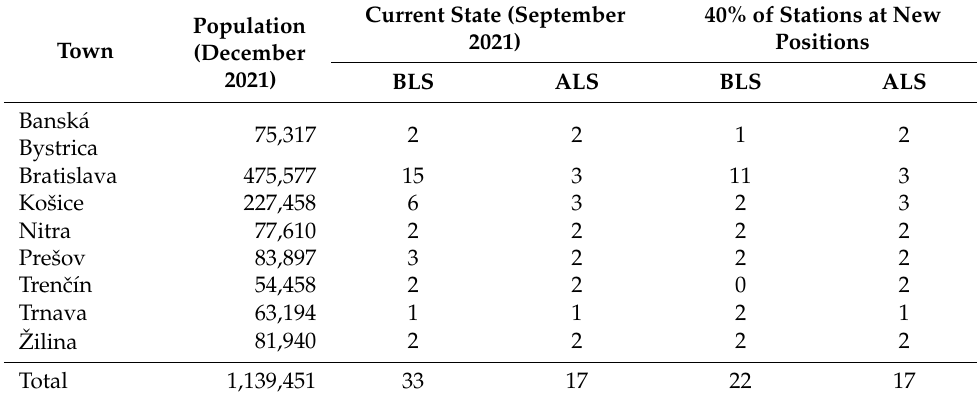
Table 5. Simulation results for the 40% scenario with and without optimization in towns.